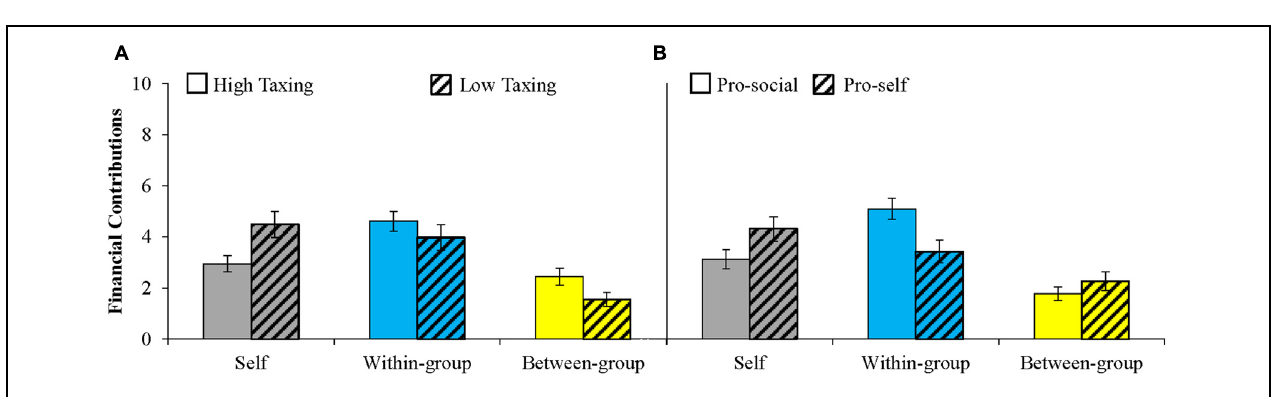
FIGURE 3 | Averaged Intergroup Prisoner’s Dilemma–Maximizing Differences Game (IPD–MD) contributions to self, within-group pool, and between-group pool (parochial altruism; range 0–10; means displayed ± 1 SE). (A) Compared to individuals in the low taxing condition